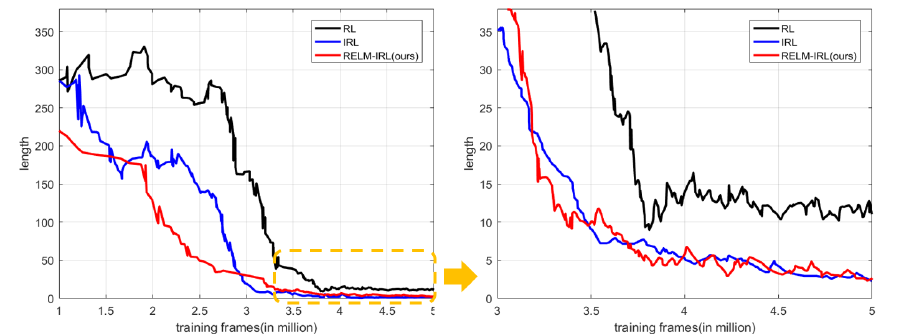
Figure 6. Comparison results of training process. The black, blue, and red curves represent the training process of RL, IRL, and RELM-IRL (ours),